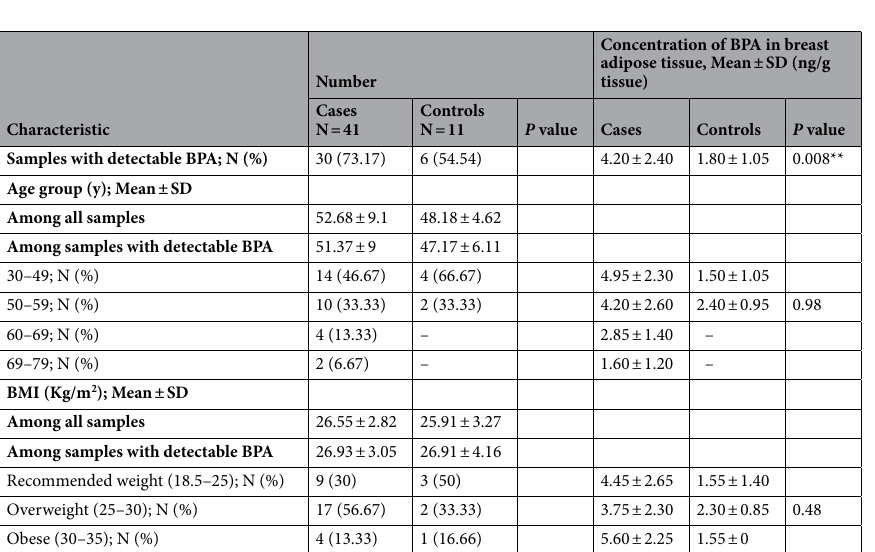
Table 4. Characteristics of subjects and tissue BPA concentrations in cases and controls. ** P < 0.01; comparison tissue BPA concentrations between cases and controls.